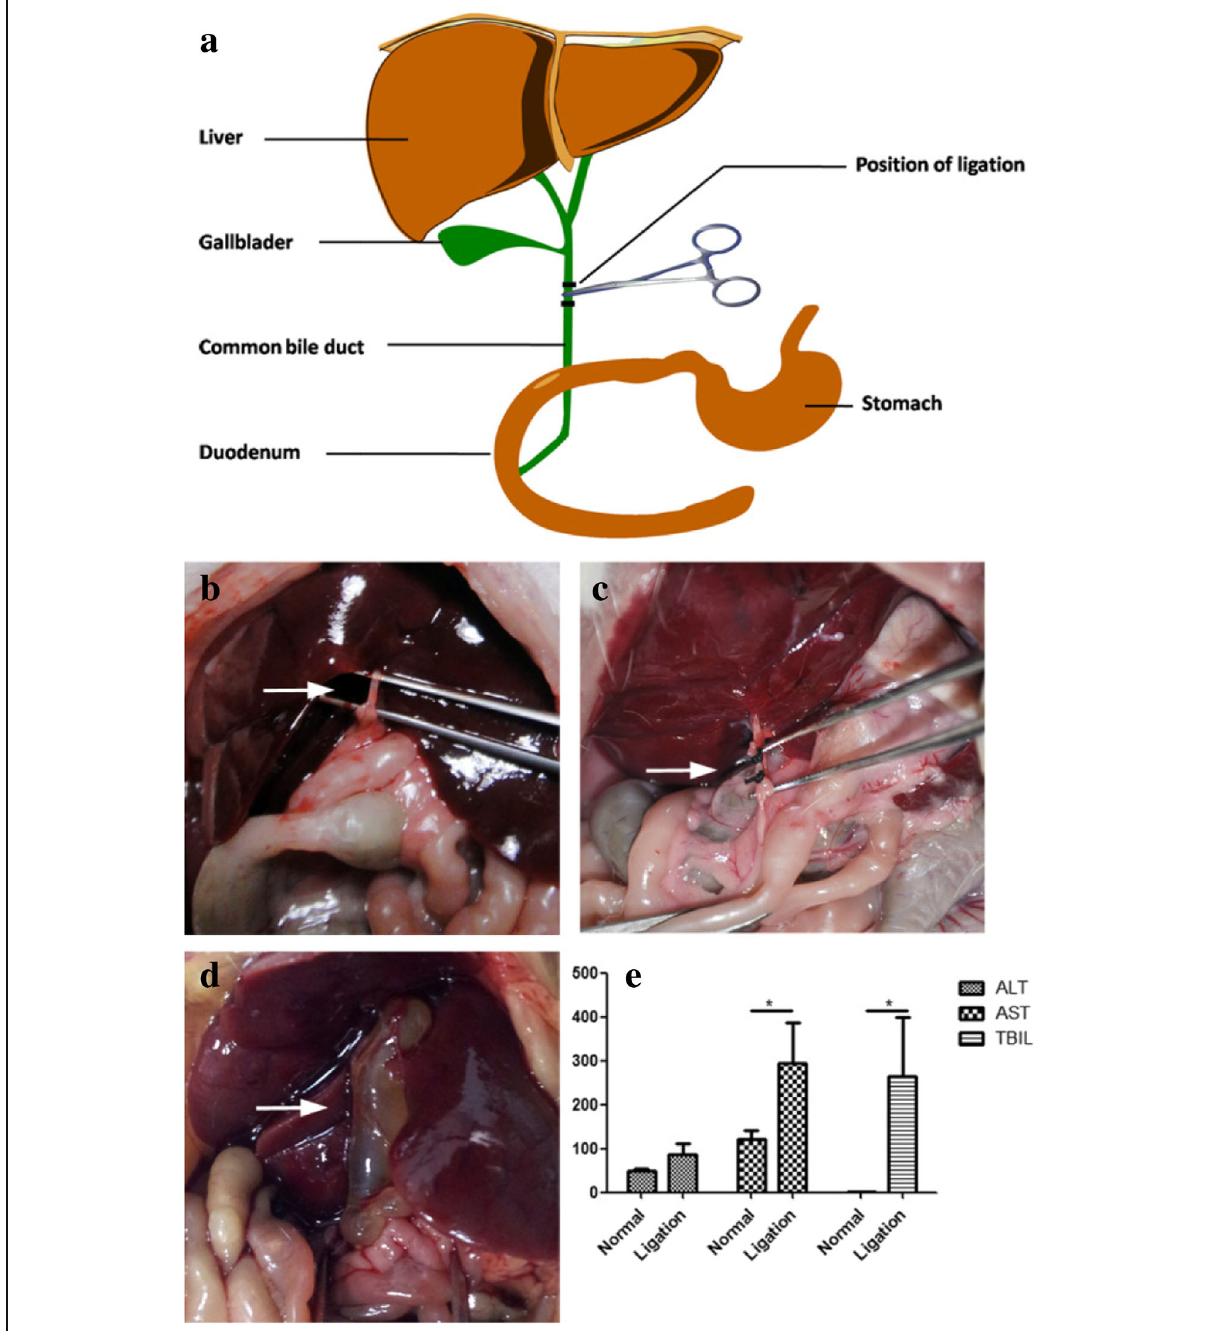
Fig. 2 a A schematic illustration of the relations of HBS with intestinal tract. b, c Ligation of CBD (white arrows). d CBD swelling on the 14th day after CBD ligation (white arrow). e Examination of the major liver function. * P <